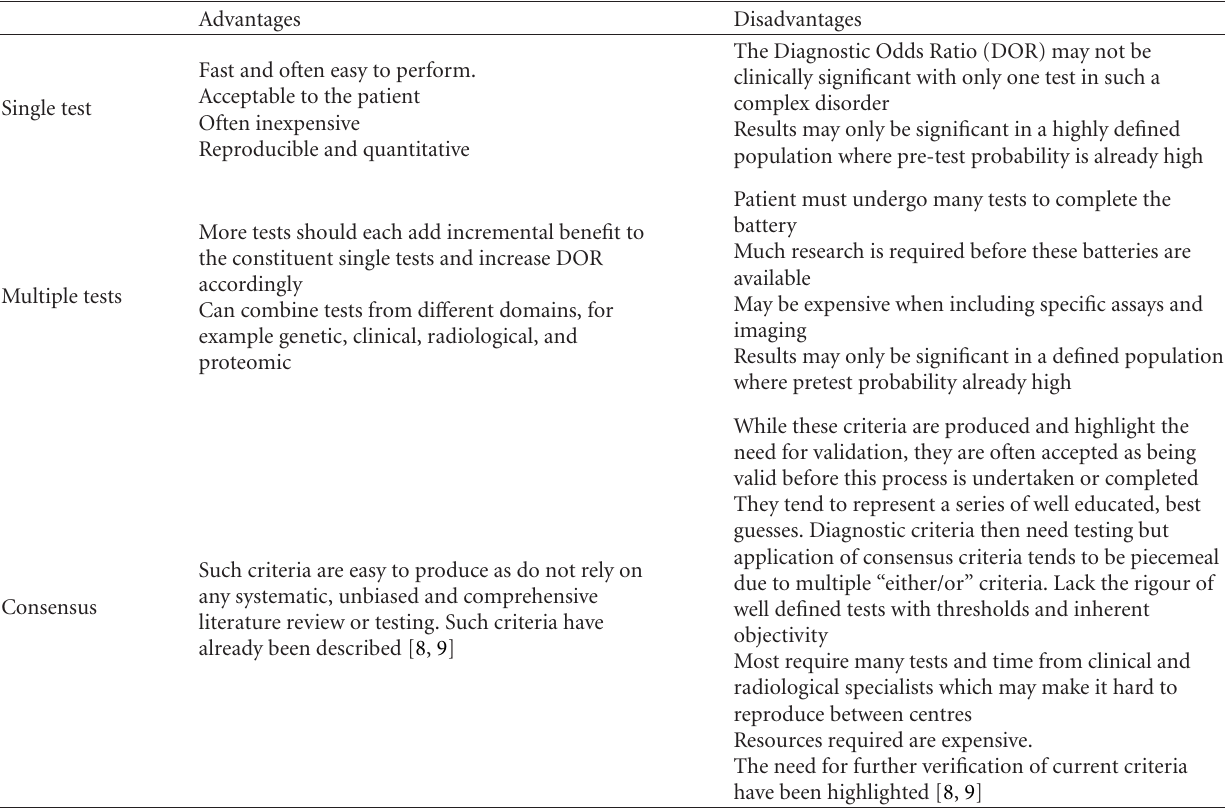
Table 1: Advantages and disadvantages of di ff erent approaches to developing an accurate diagnostic